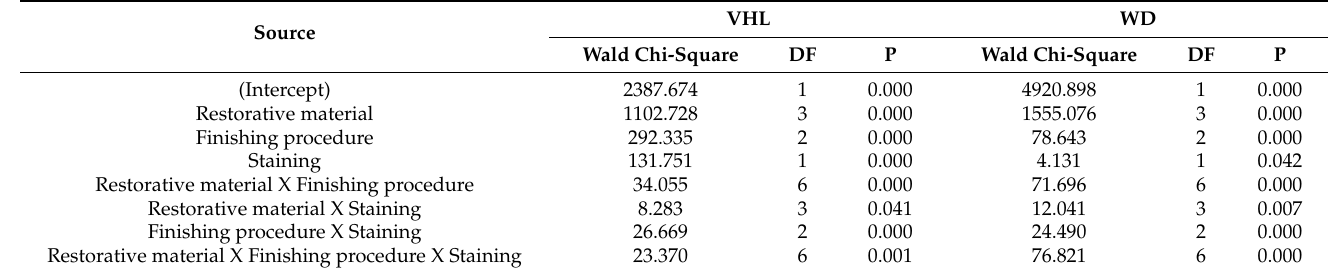
Table 4. Data of Wald test for vertical height loss (VHL) and wear depth